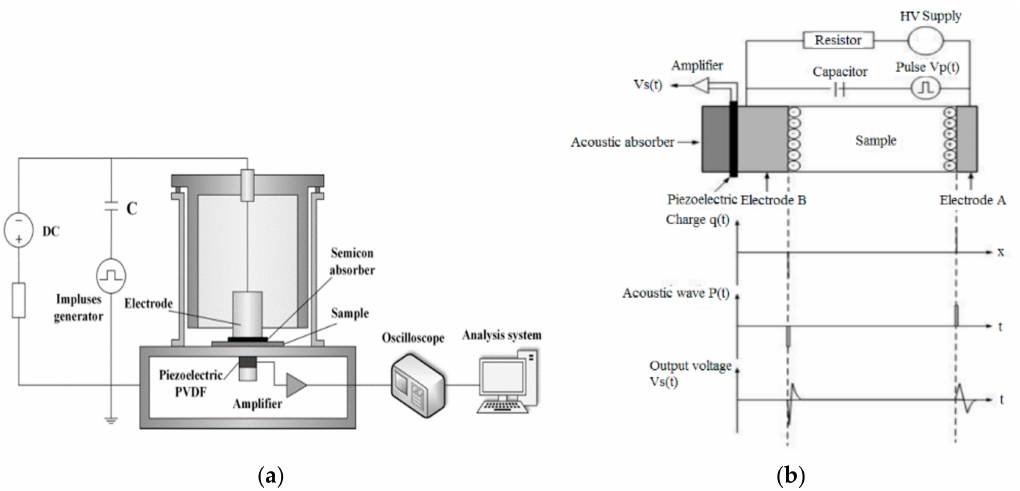
Figure 4. Schematic principle PEA method [27]: ( a ) experiment setup; ( b ) pulsed electro-acoustic (PEA)